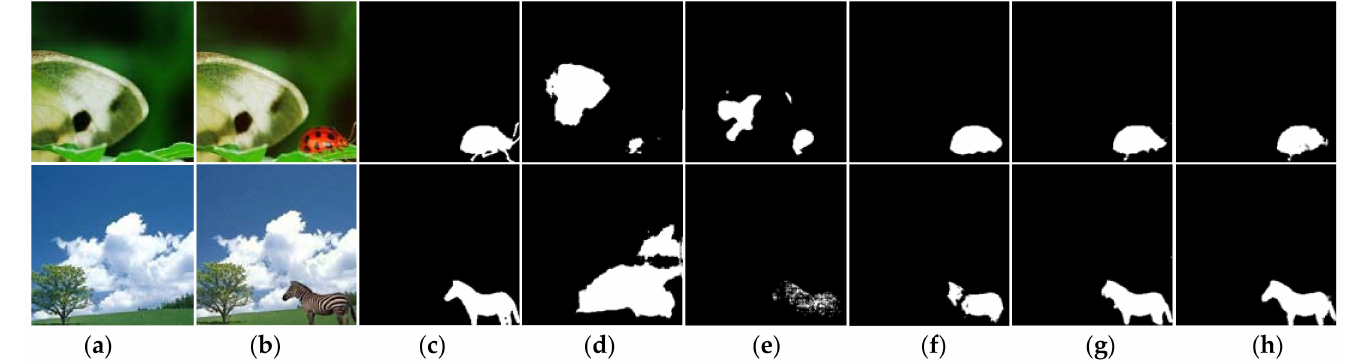
Figure 5. Ablation results of two images from CASIA2.0: ( a ) real images, ( b ) tampered images, ( c ) label image, ( d ) basic model, ( e ) basic model + SRM, ( f ) basic model + GAU, ( g ) basic model + SRM + GAU and ( h ) AttDAU-Net. Table 1. Comparative results of different tampering detection methods on CASIA1.0 and CASIA2.0. CASIA1.0 CASIA2.0 Methods Precision Recall F 1 -Score